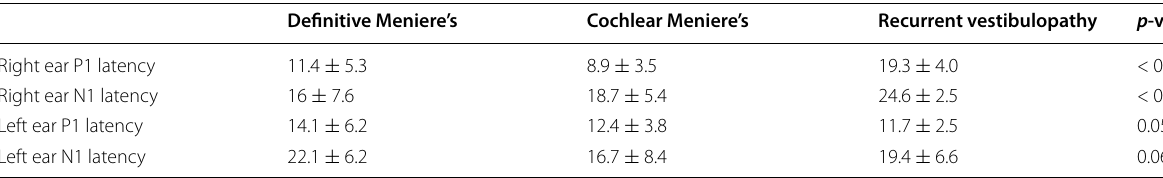
Table 11 c-VEMP P1 and N1 latencies in the left and right ear